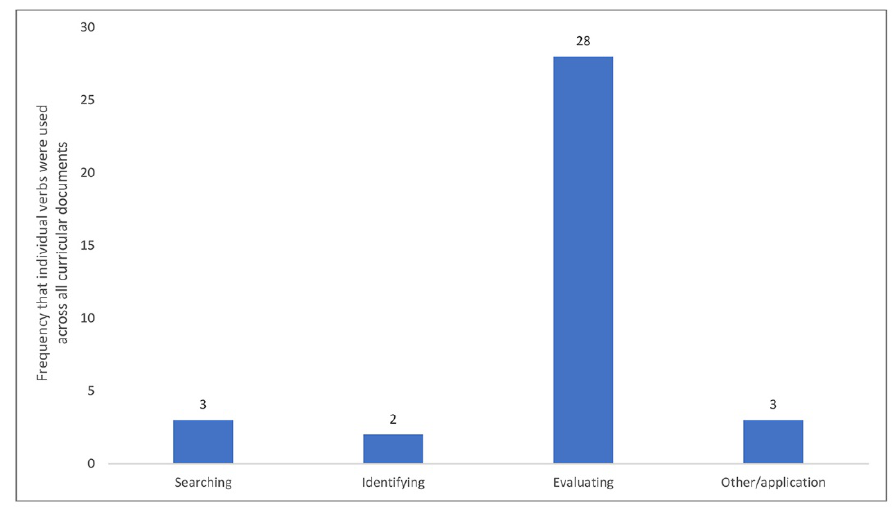
Figure 3 Categorizing analytic coding of action